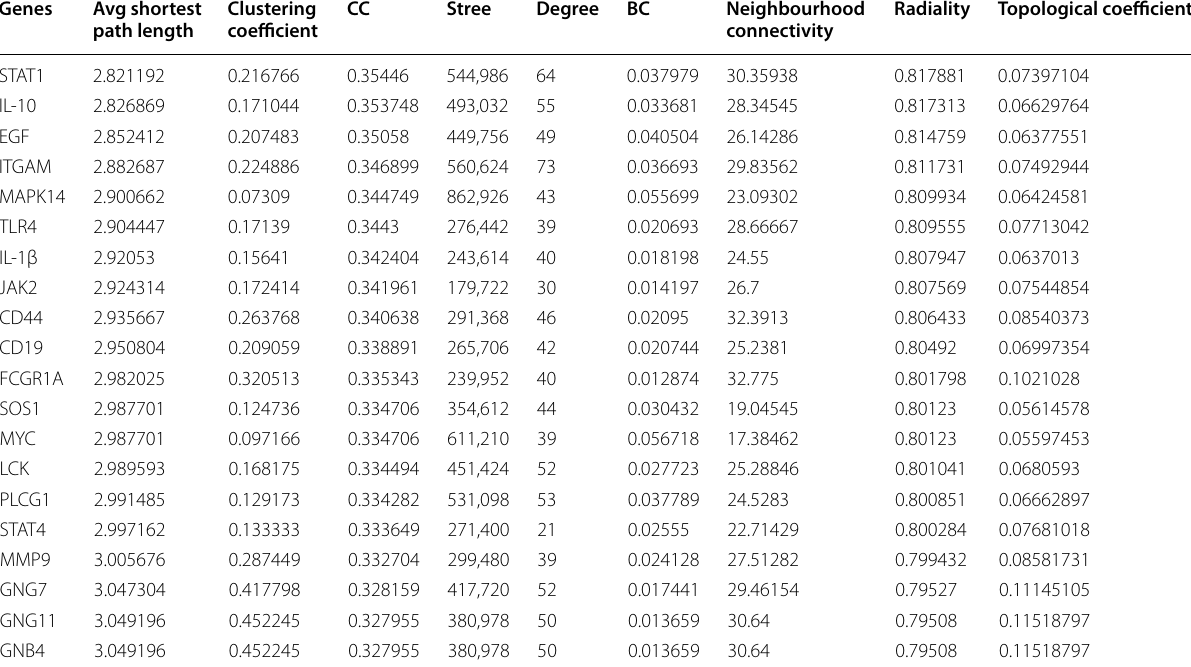
The top 20 genes with the least average shortest path length and the highest closeness centrality values are listed. The average shortest path length gives the expected distance between the two connected nodes, and genes with the shortest path length and high closeness centrality are considered as the controlling points of molecular communication. The cluster coefficient value lies in between 0 and 1. The value 0 indicates the node with less than 2